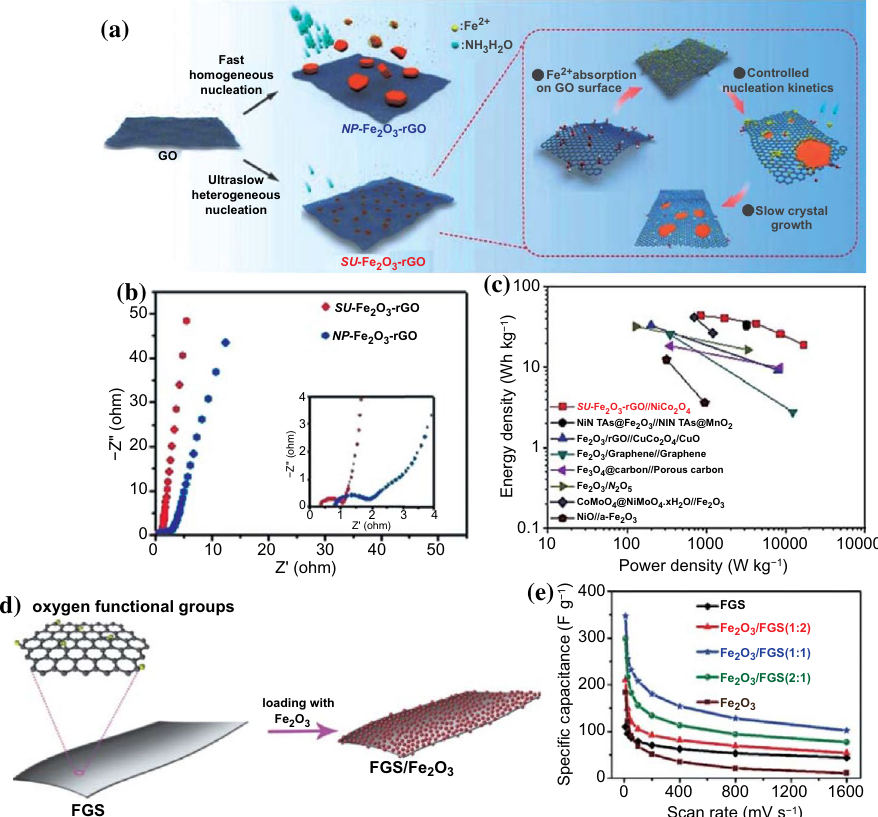
Fig. 12 a Schematic illustration of the growth of SU-Fe 2 O 3 sheets on graphene by means of controlled crystallization kinetics. b Comparison of electrochemical impedance of different size of Fe 2 O 3 -rGO. c Ragone plot related to the energy and power densities of SU-Fe 2 O 3 -rGO//NiCo 2 O 4 . Adapted with permission from Ref. [115] Copyright 2019 Wiley–VCH. d Schematic illustration of Fe 2 O 3 /FGS composite. e Specific capaci- tances of the pristine FGS, Fe 2 O 3 , and Fe 2 O 3 /FGS composite electrodes at different scan rate. Adapted with permission from Ref. [24]